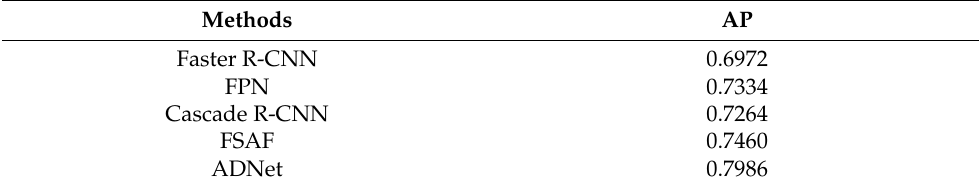
Table 4. Detection results of different methods.